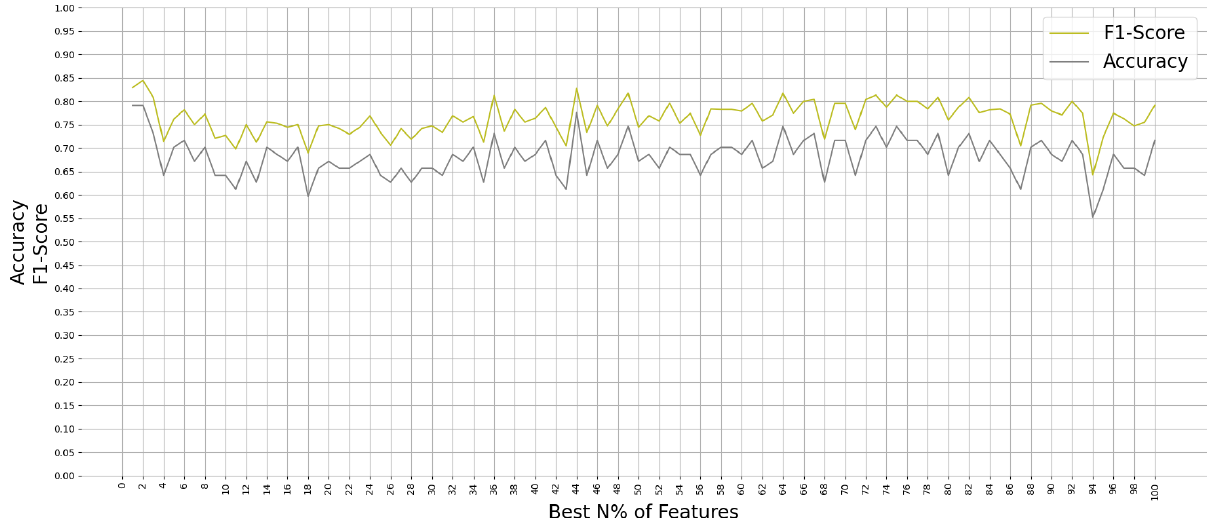
Figure 5. Performance of Random Forest on Group SN testing dataset when trained on N% of the best